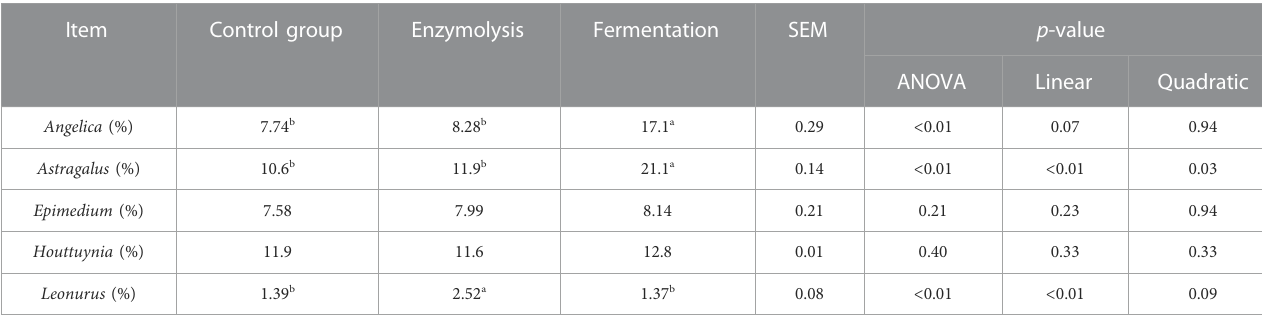
TABLE 4 Comparison of different treatment methods of Chinese